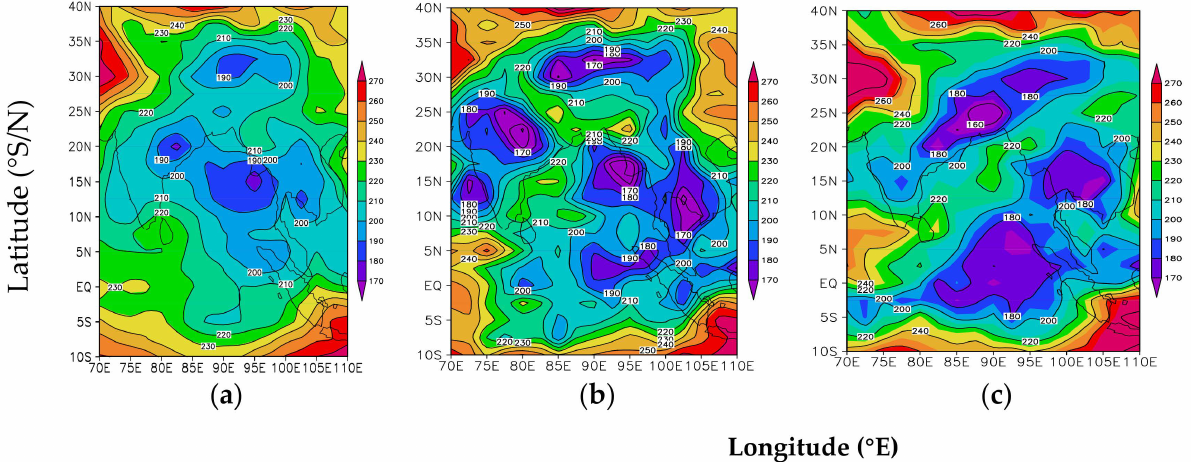
Figure 3. Outgoing long-wave radiation (OLR) distributions over the South Asia and TP regions, averaged for the ( a ) observation period, ( b ) SASM active period, and ( c ) SASM break period, with a contour interval of 10 Wm − 2